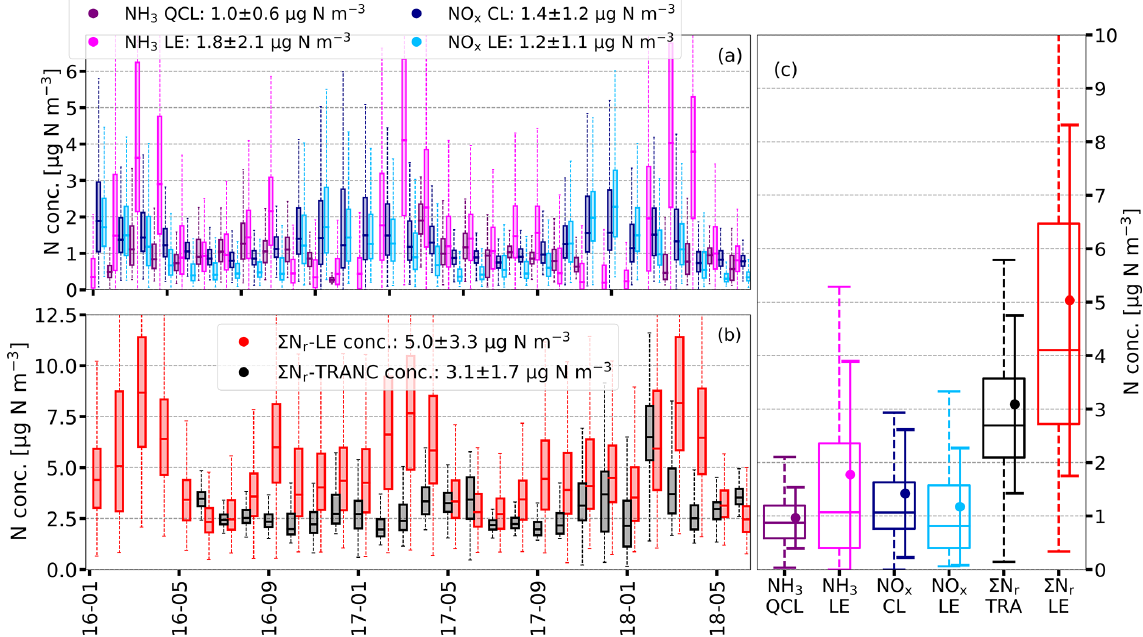
Figure 1. Half-hourly concentrations of NH 3 , NO x , and (cid:54) N r obtained from quantum cascade laser (QCL), chemiluminescence (CL), and TRANC (TRA) measurements compared to LOTOS-EUROS (LE) results displayed as box-whisker plots (box frame = 25% to 75% in- terquartile range (IQR), bold line = median, whisker = 1.5 · IQR) on a monthly basis (a, b) and for the entire duration of the campaign (January 2016 to end of June 2018) (c) in µgNm − 3 . Darker colors represent the results from measurements, brighter colors from LOTOS- EUROS. In the legends, averages and standard deviations referring to the entire campaign for NH 3 , NO x , and (cid:54) N r are